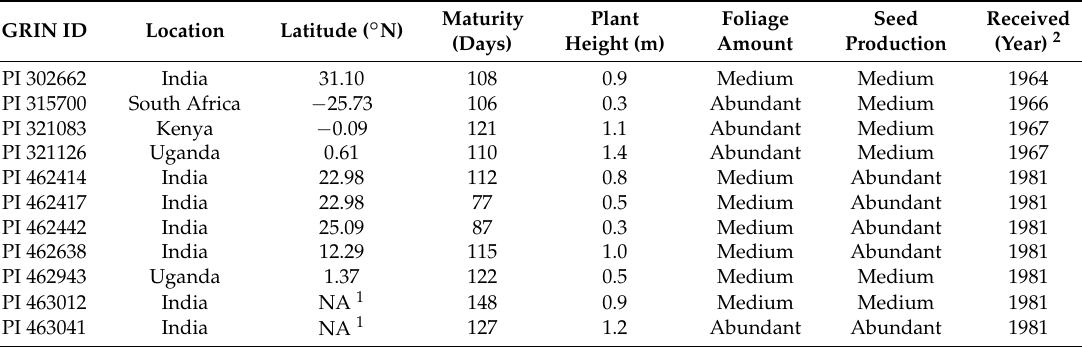
Table 1. Characteristics of 10 finger millet accessions obtained from USDA-ARS Plant Genetic Resources Conservation Unit, which is described by the Germplasm Resources Information Network (GRIN). GRIN ID Location Latitude ( ◦